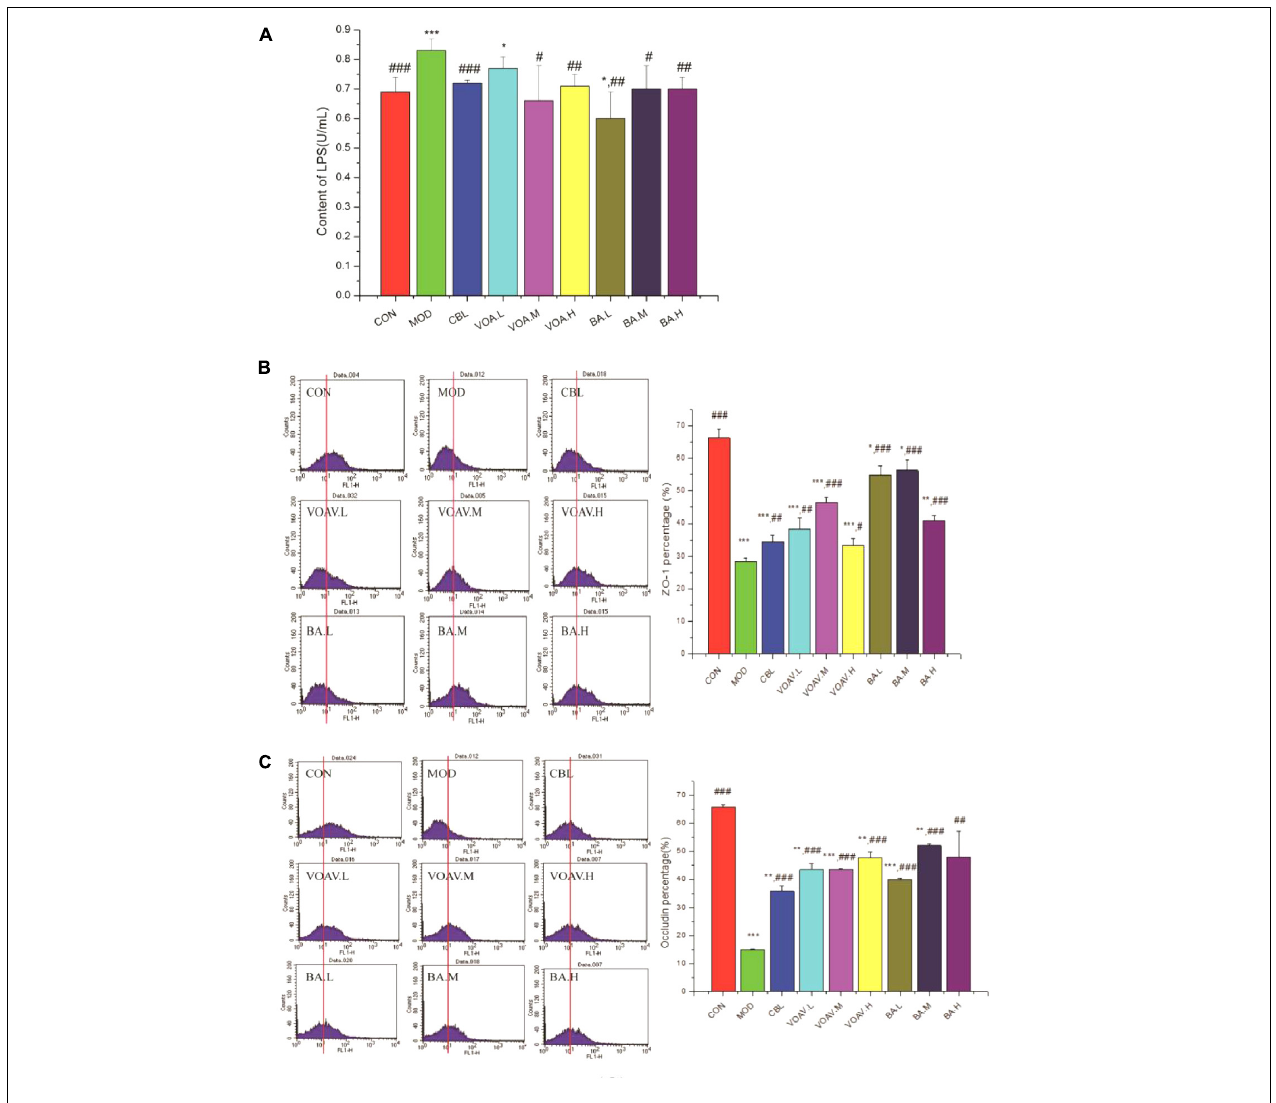
FIGURE 7 | Effects of VOA on enterogenous endotoxin and intestinal mucosal barrier regulation. (A) LPS in hepatic portal veins, n = 6 was increased after 5-FU. VOA and BA blocked increases in LPS, (B) ZO-1, n = 6, and (C) occludin, n = 6. In the histogram, the data of the horizontal coordinate that were more than 10 1 were counted and were used as original data to draw the bar chart. The histograms of ZO-1 and occludin show a decrease after 5-FU. VOA and BA increased proteins ( p < 0.01 and p < 0.001). Values are means ± SD. ∗ Significant difference compared to the controls. # Significant difference compared to the model and controls. ∗ p < 0.05, ∗∗ p < 0.01, ∗∗∗ p < 0.001 , # p < 0.05 , ## p < 0.01, and ### p < 0.001.